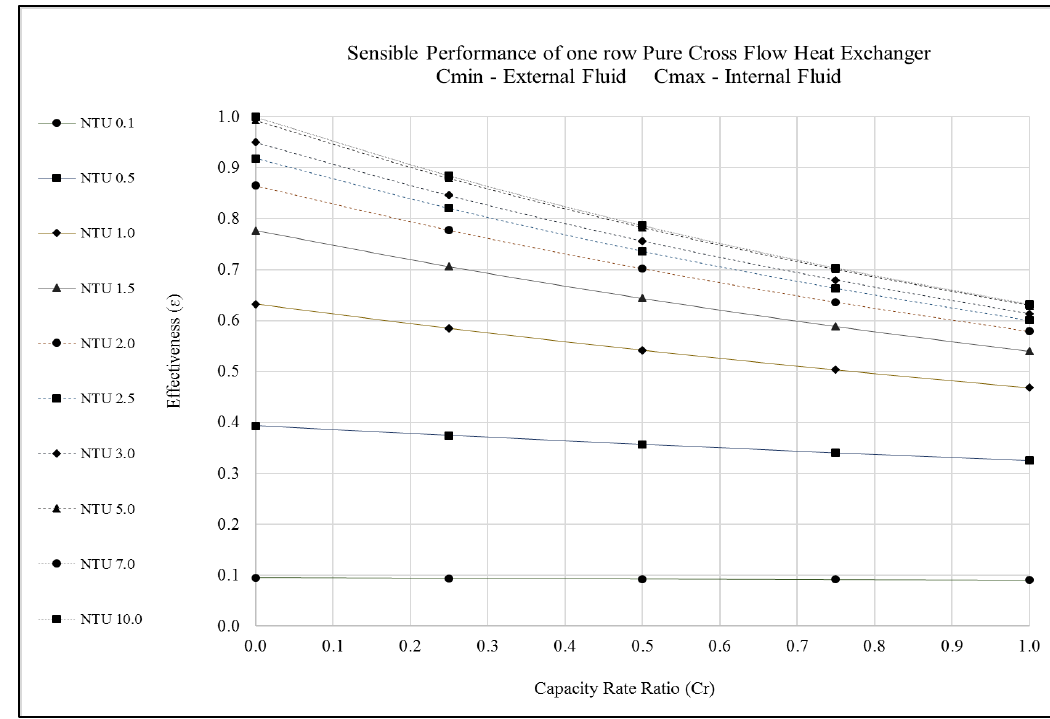
Energies 2021 , 14 , 5489 Figure 3. Performance predictions of a 1-row pure cross flow heat exchanger. Figure 3. Performance predictions of a 1-row pure cross flow heat exchanger.